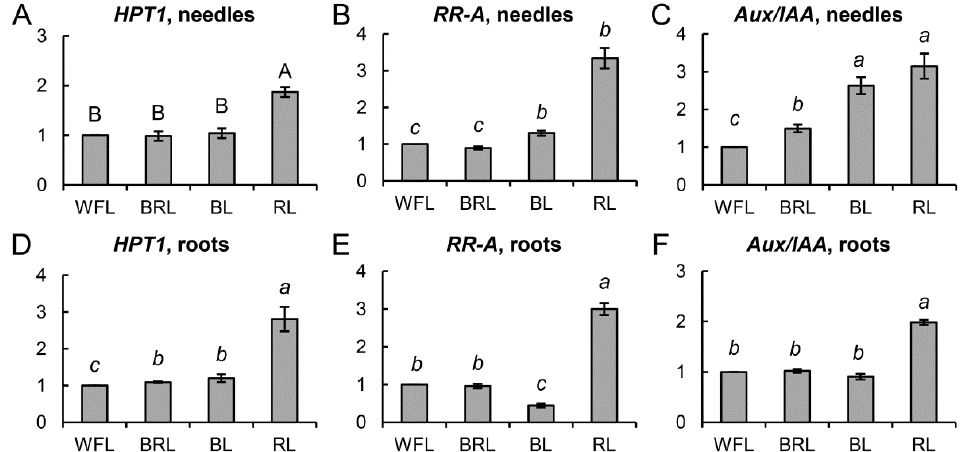
Figure 4. Effect of light quality on the transcript levels of different groups of genes in P. sylvestris seedlings. HPT1, RR-A, and Aux/IAA in needles( A – C ) and roots ( D – F ). The mRNA levels of the genes were expressed as the BRL, BL, RL/WFL ratio (fold change BRL, BL, RL/WFL). Values are the mean ± SE. Different capital letters denote statistically significant differences in the means at p < 0.05 (ANOVA followed by Duncan ’ s method). Different italic letters denote statistically significant differences in the means at p < 0.05 (Kruskal – Wallis ANOVA of the ranks followed by the Student-Newman-Keuls post hoc test).